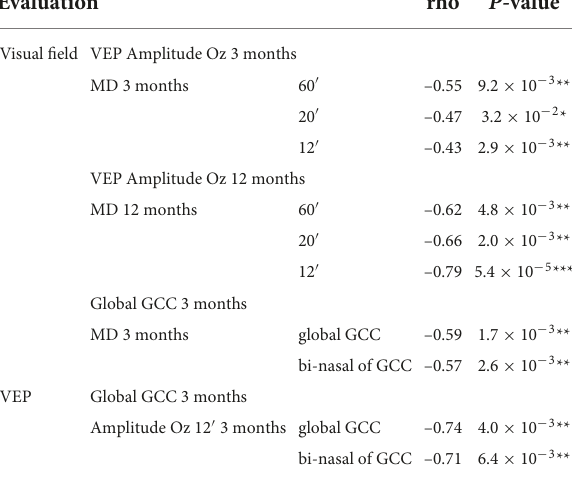
TABLE 4 Structure–function associations in pituitary